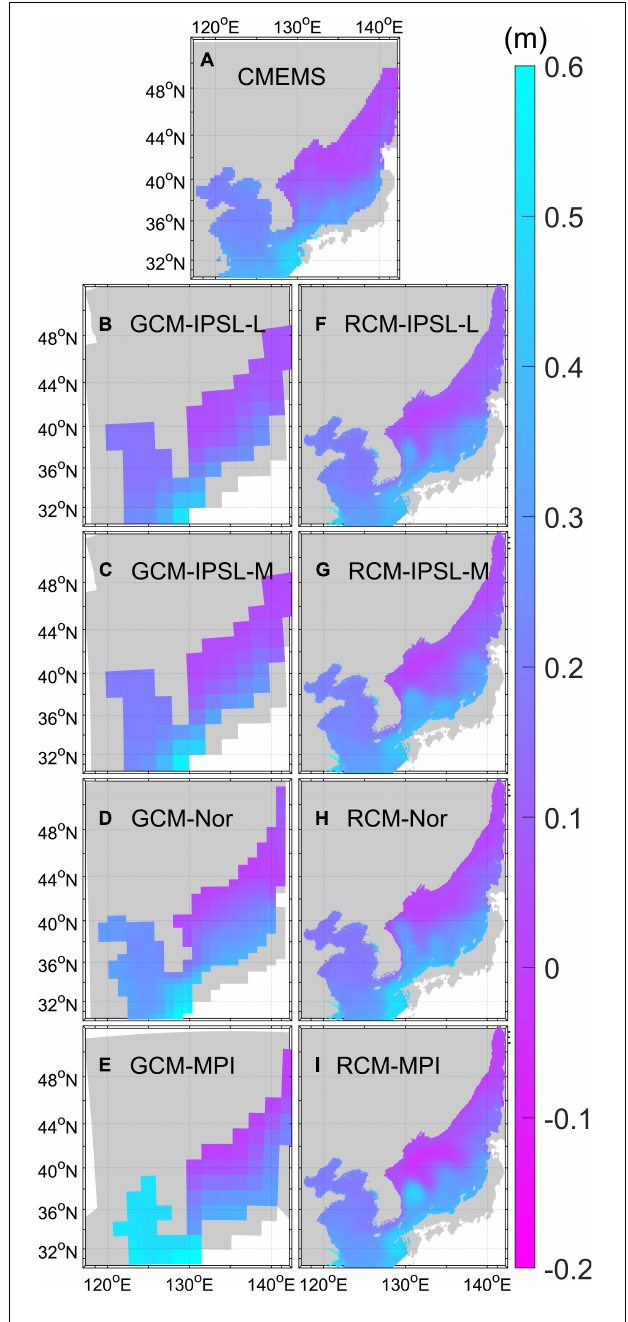
FIGURE 5 | Horizontal distribution of the mean sea-level (unit: m) in the NWP marginal seas: (A) Mean sea-level calculated from CMEMS absolute dynamic topography, and those of the (B–E) GCMs and (F–I) RCMs, 1993–2005.